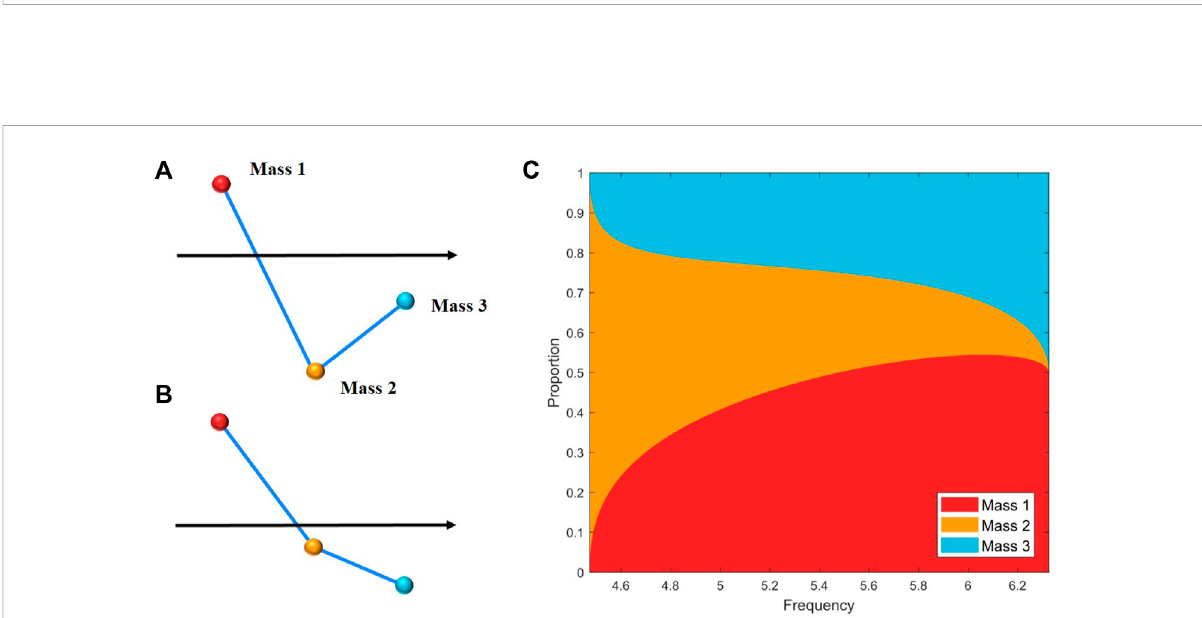
FIGURE 5 Wave mode shapes at frequency (A) f = 4.7 and (B) f = 6.1. (C) Proportion of magnitudes of wave mode shapes for Mass 1, 2, and 3 in the band